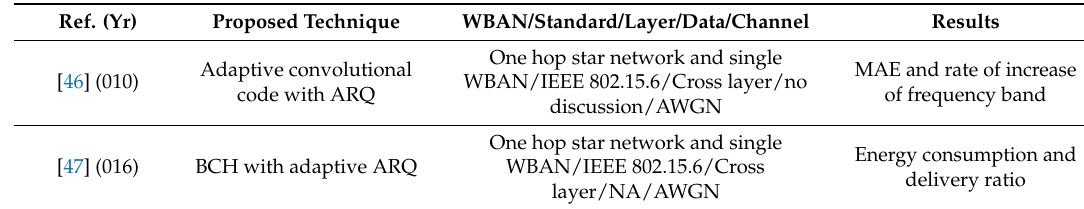
Table 6. A review of HARQ-I based